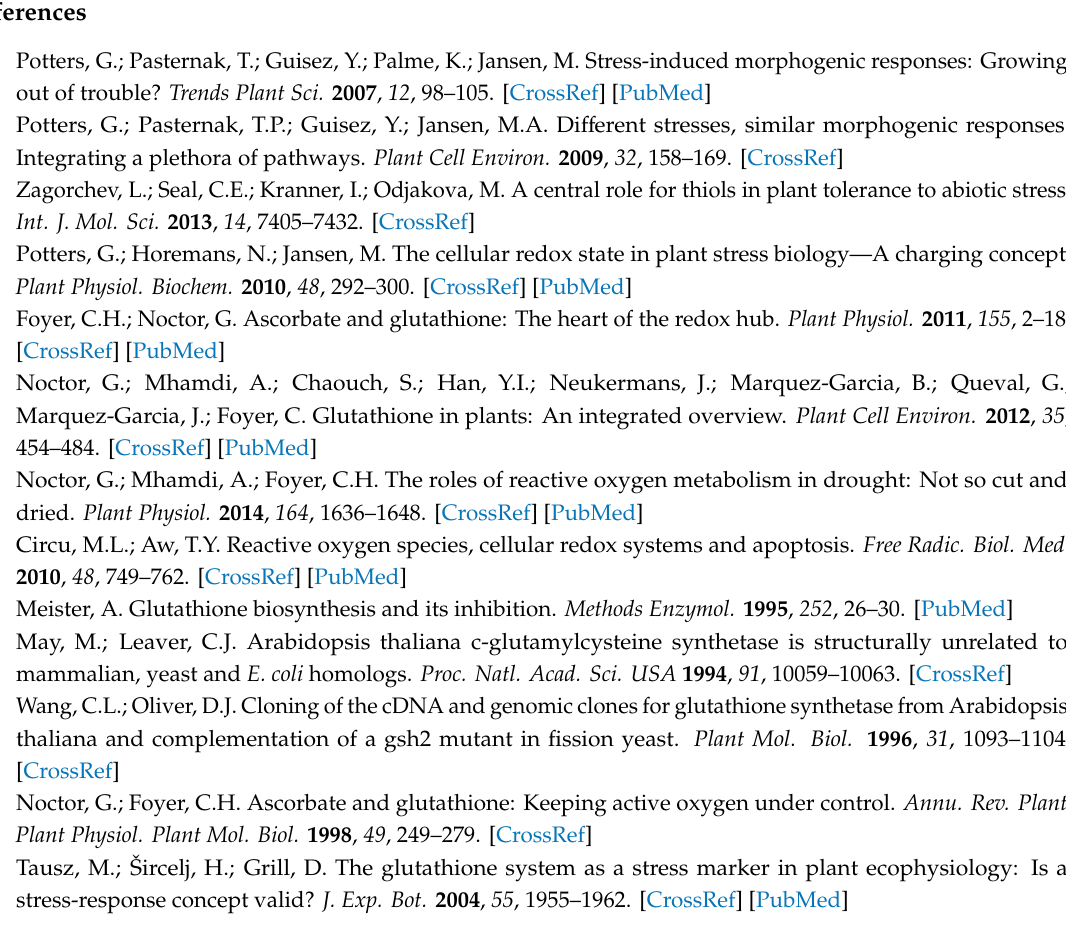
Table S1: Root length in rml1 mutant and rml1 mutants treated with 1 mM GSH. Three-day-old rml1 seedlings were treated with 1 mM GSH or without (mock treated) during 3 days. Means ± SDs are presented; Table S2: Primers for auxin responsive genes and ACTIN2